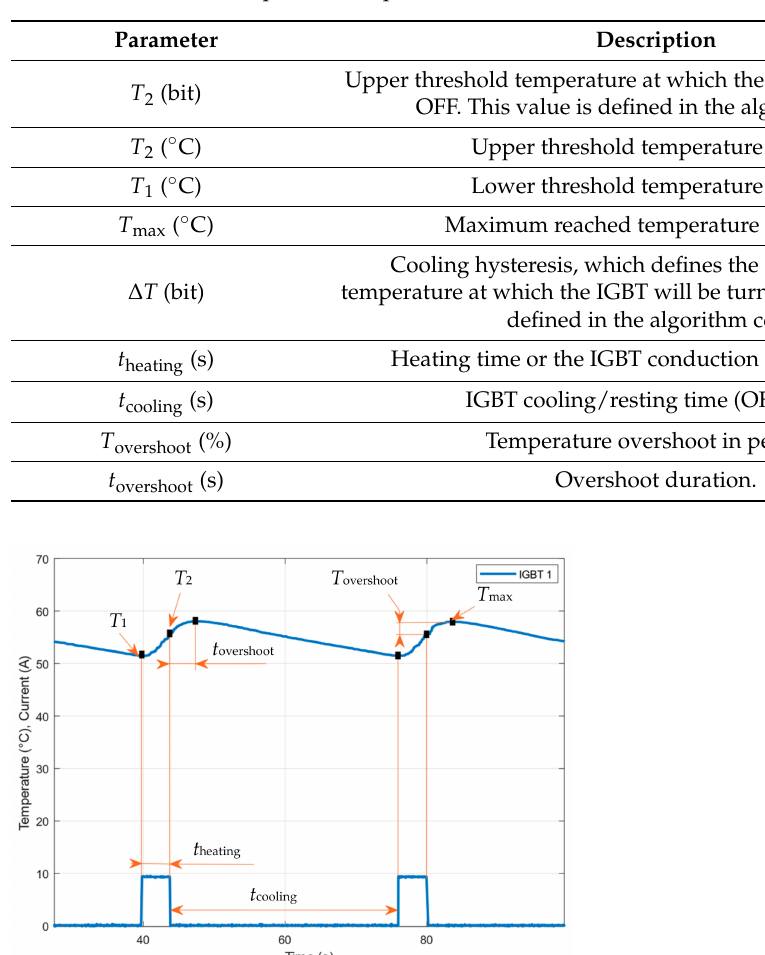
Table 3. Parameter description of the processed MATLAB data.